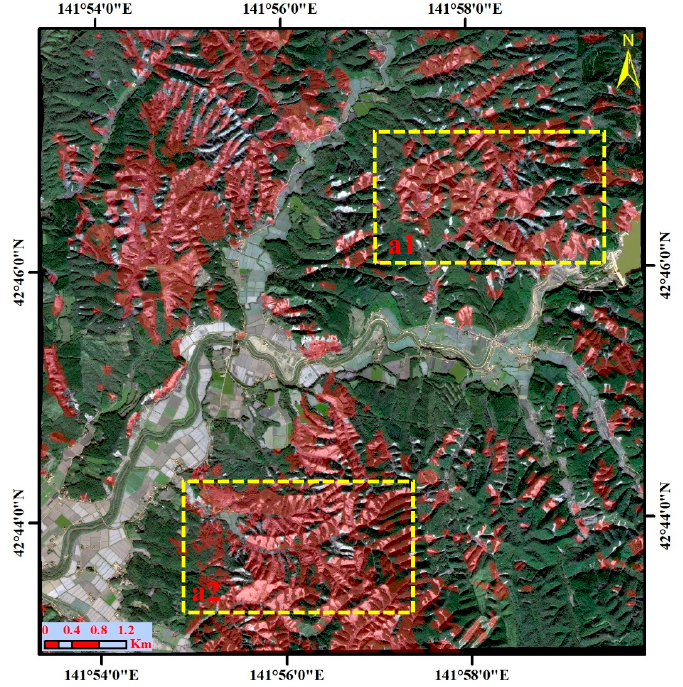
Figure 8. The landslide classification map using only the descending SAR coherence (case 1). The background is a GeoEye-1 image taken on 20 October 2018.